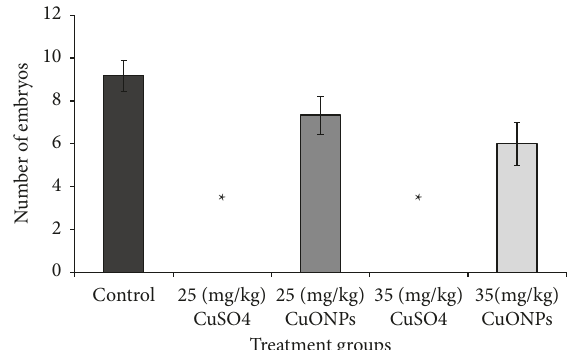
Figure 10: The effect of CuO NPs and CuSO 4 0.5 (H 2 O) on fertility and number of fetuses in